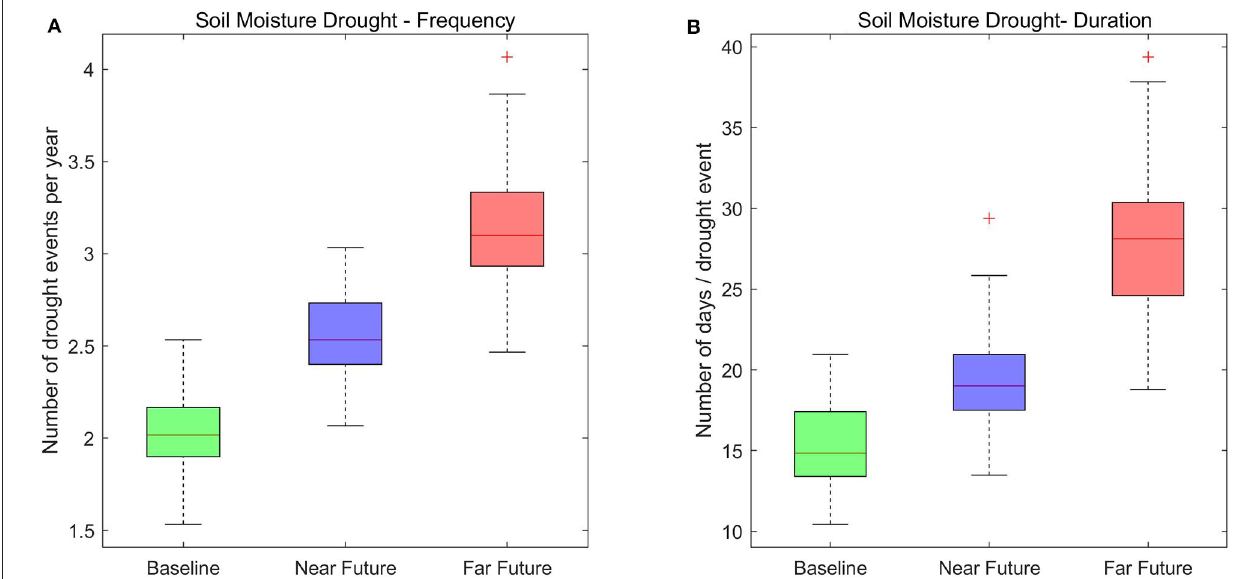
FIGURE 10 | Changes in frequency (A) and duration (B) of soil moisture droughts in